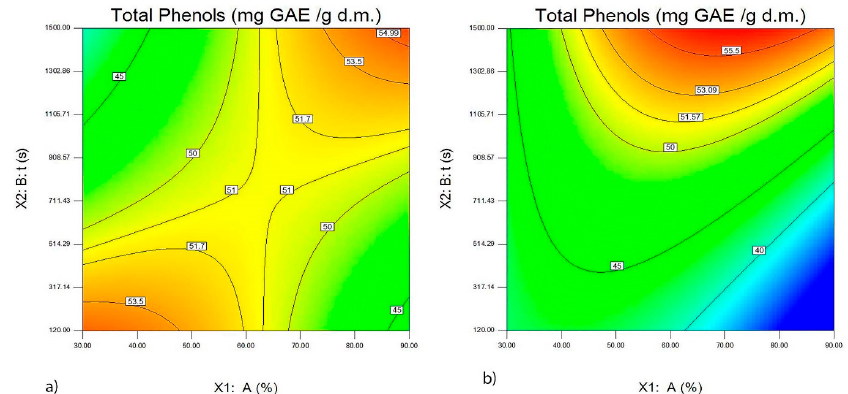
Figure 1. The e ff ect of the probe with a diameter of 40 mm, the amplitude A (%), and ultrasound Figure 1. The effect of the probe with a diameter of 40 mm, the amplitude A (%), and ultrasound extraction time t (s), on the quantity of total phenols (mg GAE/g d.m.) in the wine lees extracts from extraction time t (s), on the quantity of total phenols (mg GAE / g d.m.) in the wine lees extracts from the the Merlot variety ( a ) and wine lees from the Vranac variety ( b ). Merlot variety ( a ) and wine lees from the Vranac variety ( b